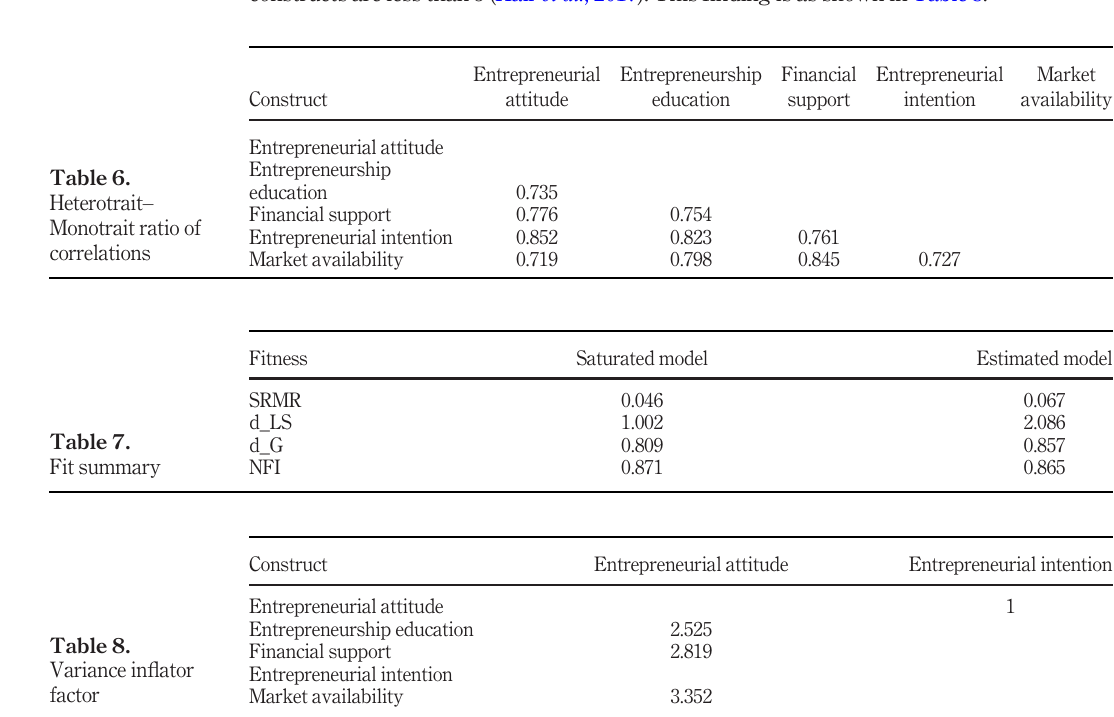
Table 8. Variance in fl